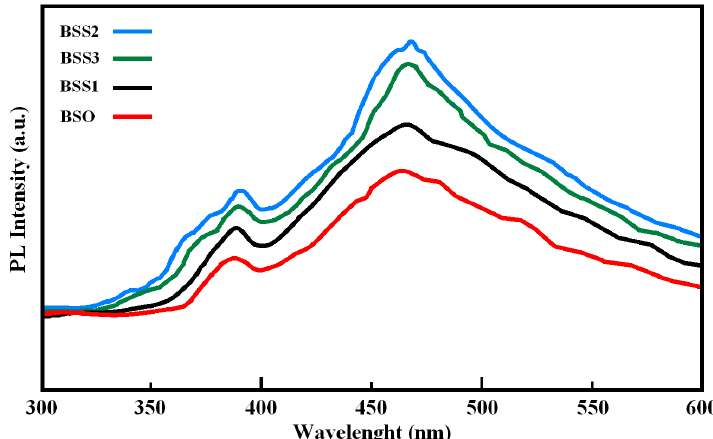
Fig. 6. Photoluminescence spectra of BSO, BSS1, BSS2, and BSS3 thin